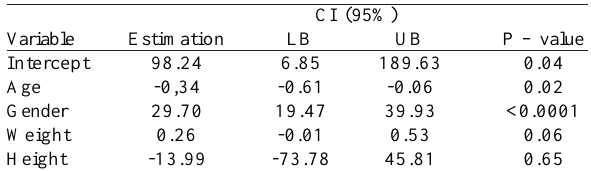
Table 4. Estimated MEP linear regression model containing all covariates. (CI=confidence interval; LB=lower bound; UB=upper bound)